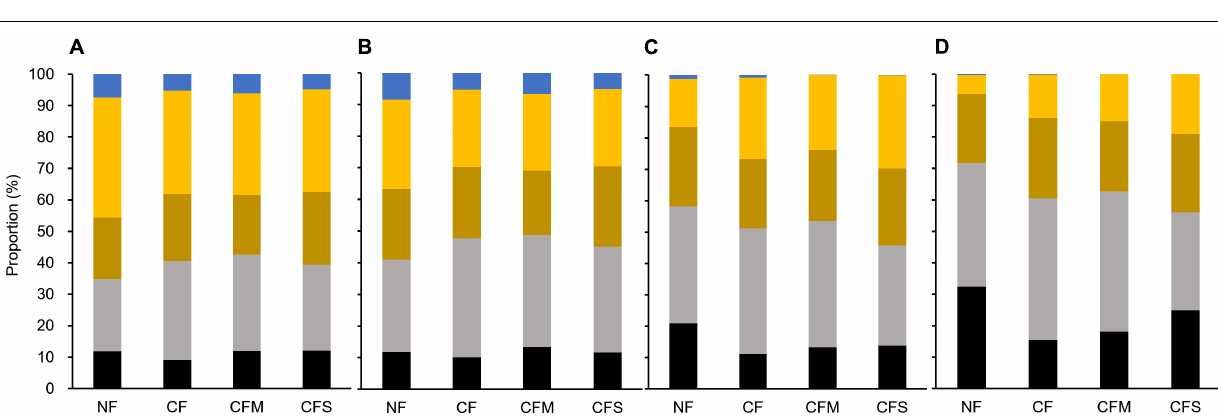
FIGURE 6 | Proportion of mass (A) , SOC (B) , bacterial abundance (C) , and fungal abundance (D) by different-size fractions of soil aggregates under the fertilization treatments. Black, L-MacA; gray, MacA; Brown, MicA; yellow, F-MicA; blue, F-Clay. NF, no fertilizer applied; CF, compound inorganic fertilizer; CFM, inorganic fertilizer combined with swine manure; CFS, inorganic fertilizer combined with residue